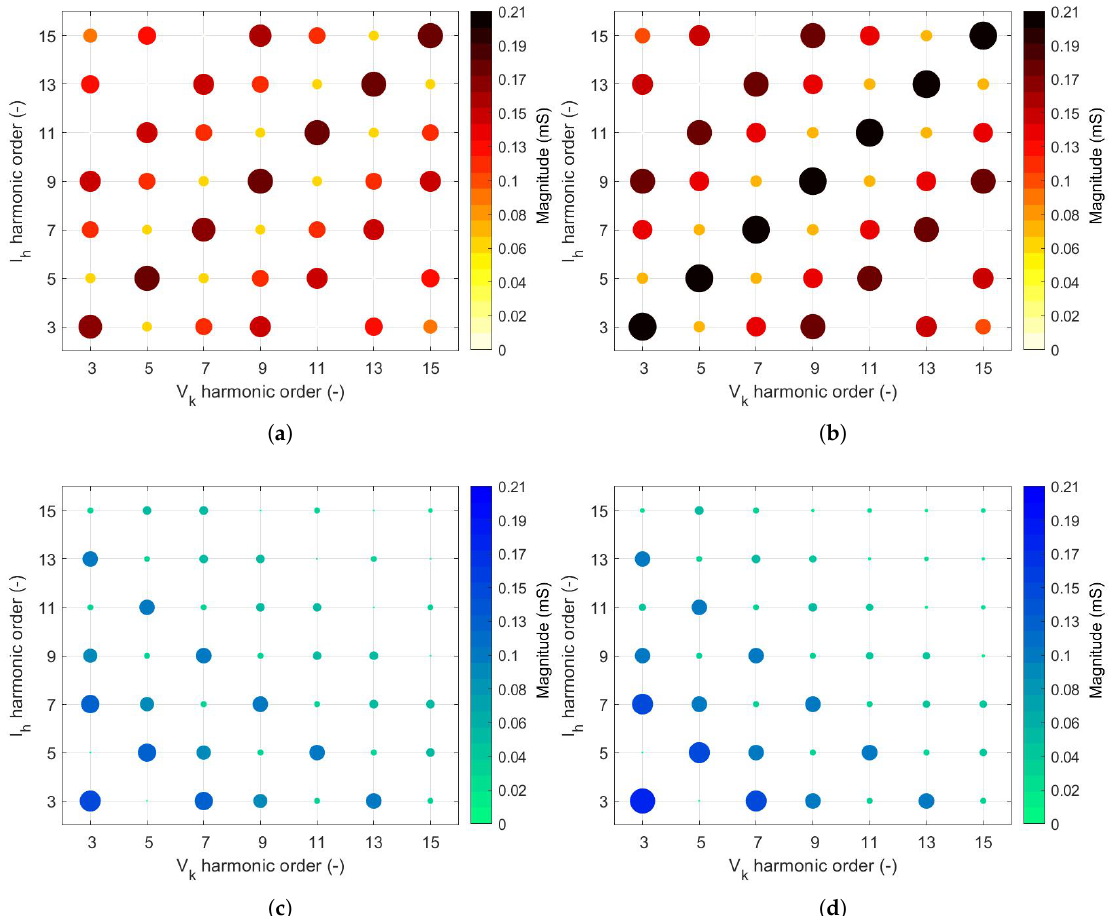
Figure 17. Magnitude of frequency coupling matrices of the Type C LED lamp: ( a ) Y + FT; ( b ) Y + PT; ( c ) Y − FT; and ( d ) Y −